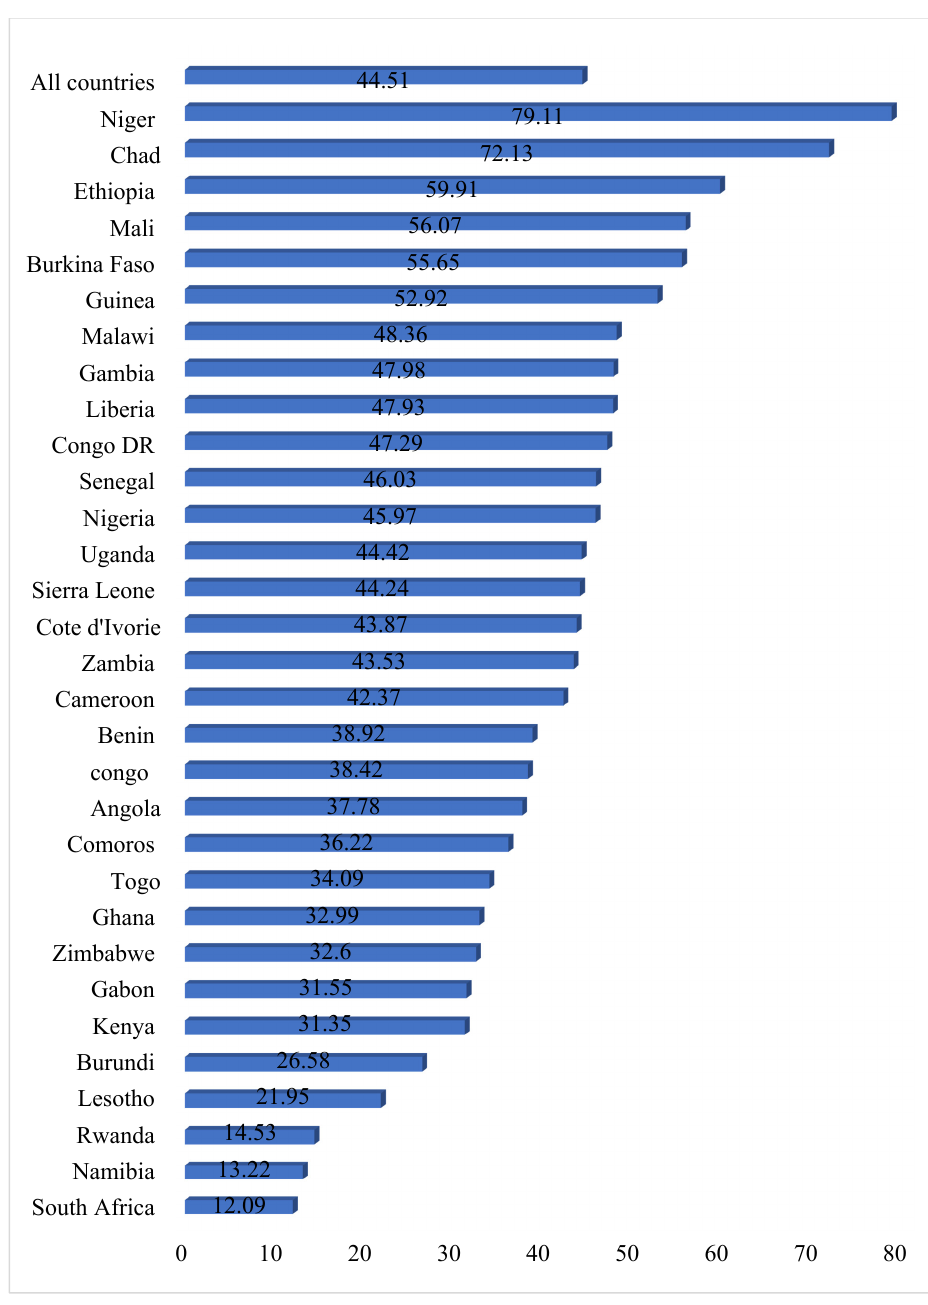
Figure 1. Bar chart showing the prevalence of child marriage in sub-Saharan Africa.